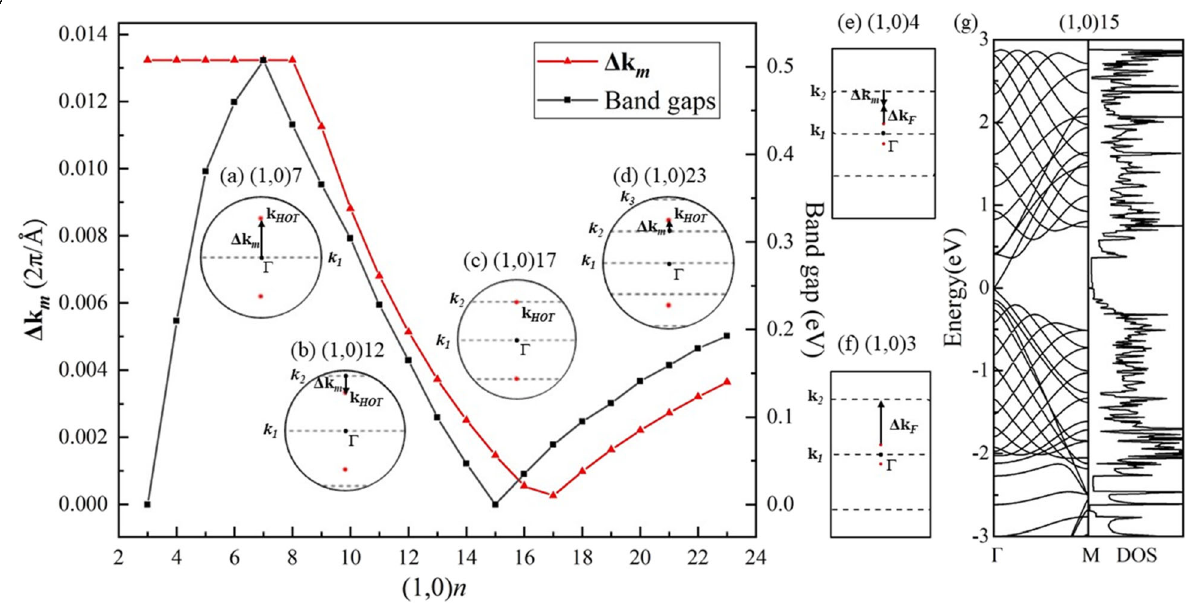
Fig. 9 Calculated band gaps (black line) and distance Δ k m (red line) between k HOT and the nearest k line in (1,0) n tubes. Inserted graphs are the BZ near the Γ point with allowed k lines k m ( m = 1, 2, 3) (dash lines) and the Fermi point of HOT graphene nanotubes k HOT (red points) in tube ( a ) (1,0)7, ( b ) (1,0)12, ( c ) (1,0)17, ( d ) (1,0)23, ( e ) (1,0)4, and ( f ) (1,0)3. ( g ) Band structures and DOS of tube